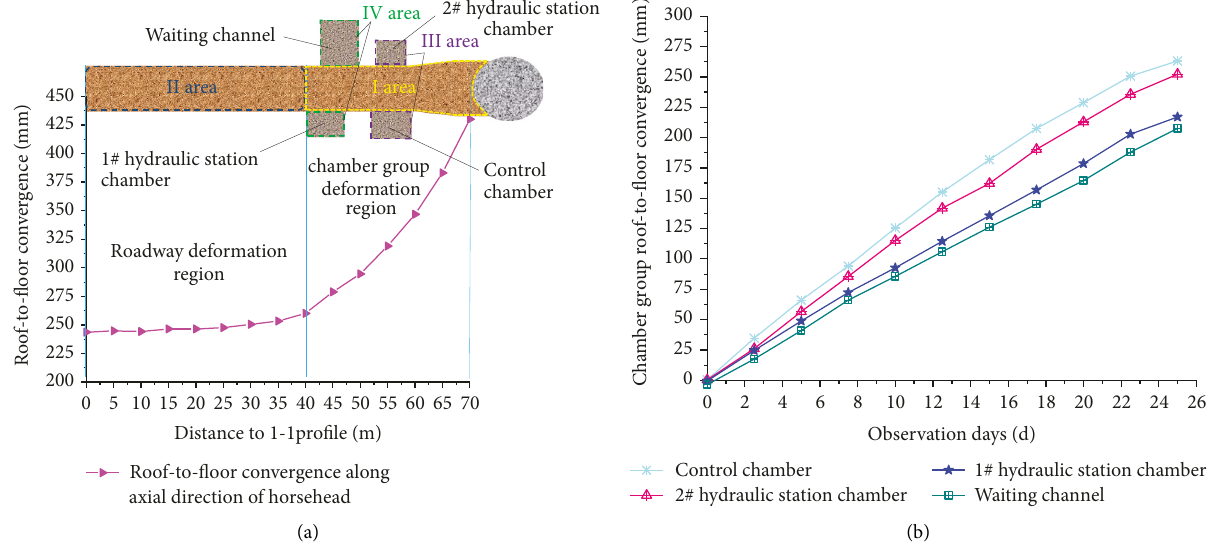
Figure 3: Convergence state of surrounding rock: (a) variation of relative convergence of roof-to-floor at different positions along roadway axis. (b) Variation of relative convergence of roof-to-floor of each chamber with time changing.